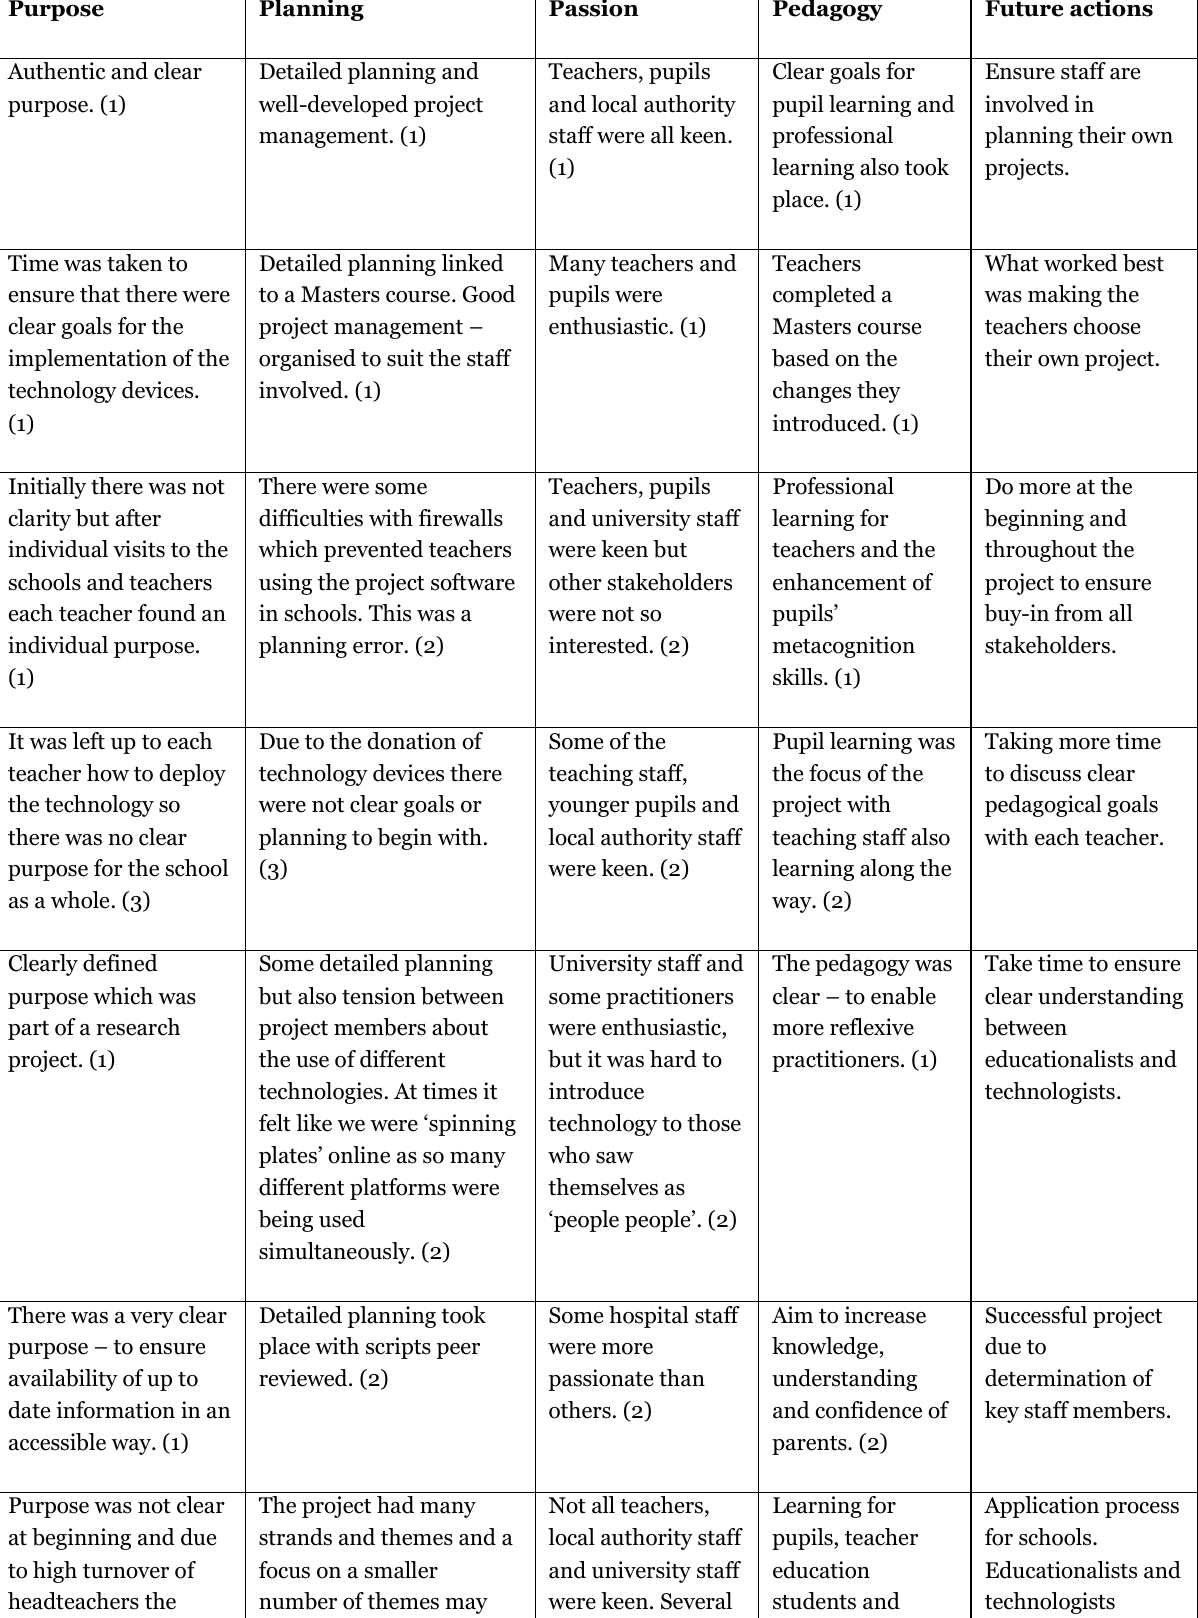
Table 2 Reflections on my experiences of seven educational technology projects (rated 1 for excellent to good, 2 for adequate and 3 for